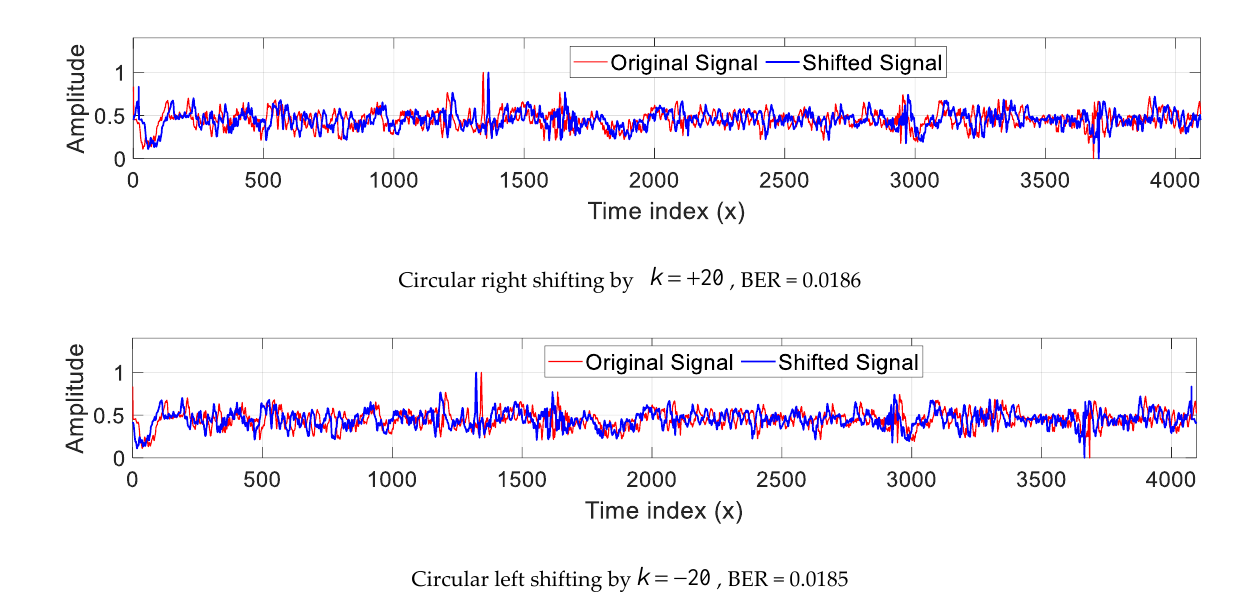
Figure 21. Original EEG signal and its circularly shifted versions with the corresponding BER values.